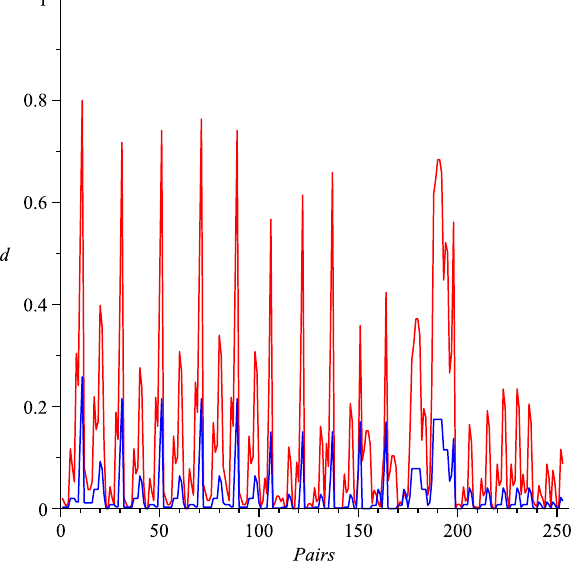
Figure 2. Values of d E ( T , T 0 ) (red) and d Ig ( T , T 0 ) (blue). The Y-axis denotes the values of the distance measure and the X-axis denotes the graph pairs.